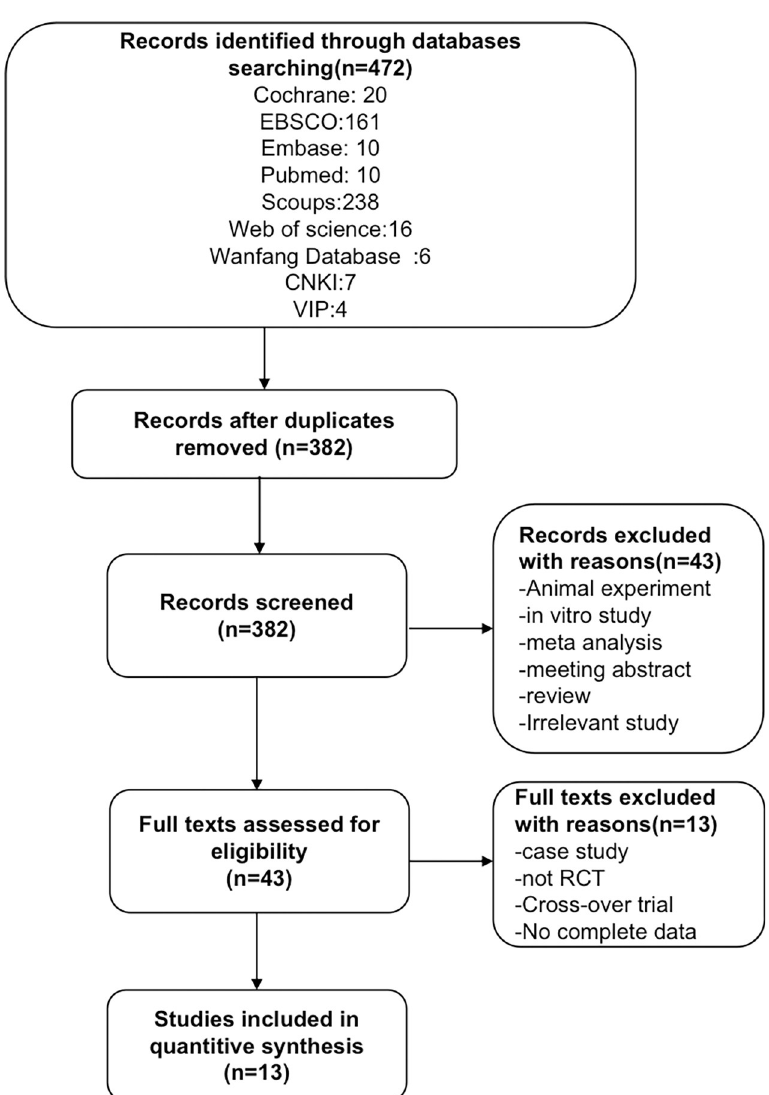
Fig 1. The PRISMA flow chart of literature